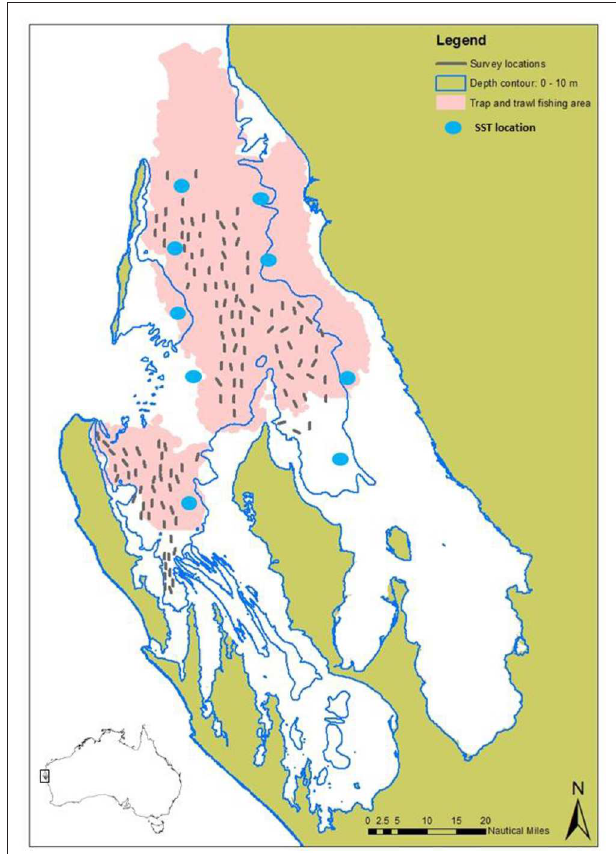
FIGURE 1 | Map showing the main commercial fishing grounds of the trap and trawl sectors (from log book data) combined (pink), overlayed with the survey sites (gray lines) sampled during the fishery-independent crab surveys, and locations for the SST satellite data (blue